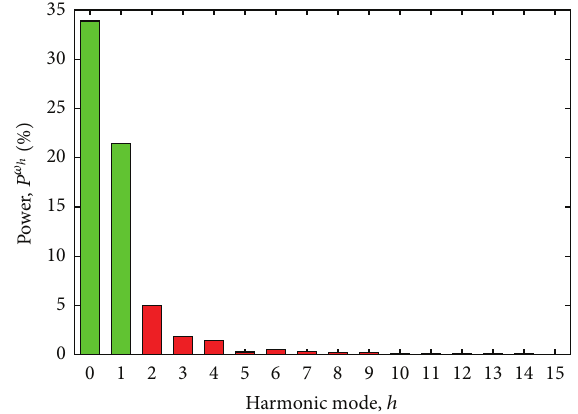
pattern at the central angular frequency 𝜔 0 in the broadside direction ( 𝜃 𝜔 0